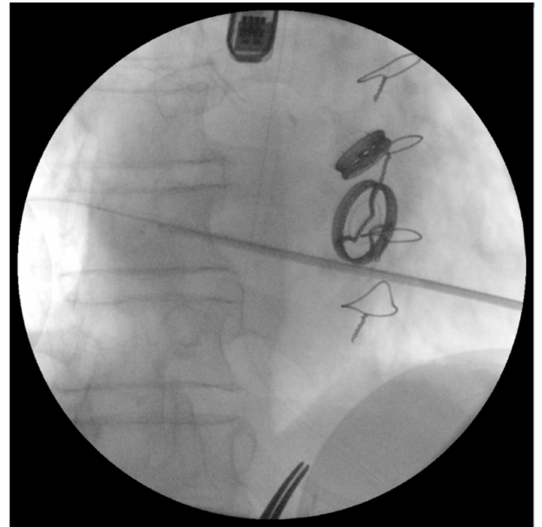
Figure 2. Easy engagement of mitral postero-medial paravalvular